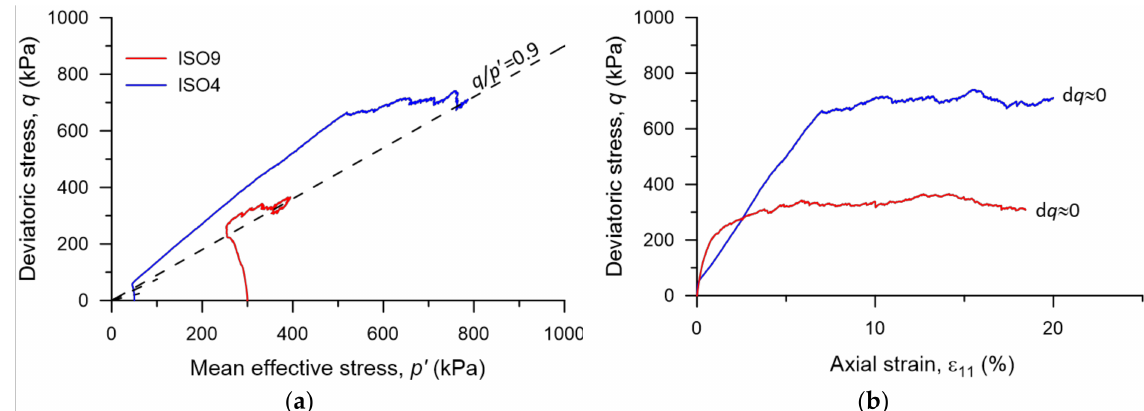
Figure 3. The observed undrained behaviour in the ( a ) q - p (cid:48) and ( b ) q - ε 11 spaces.